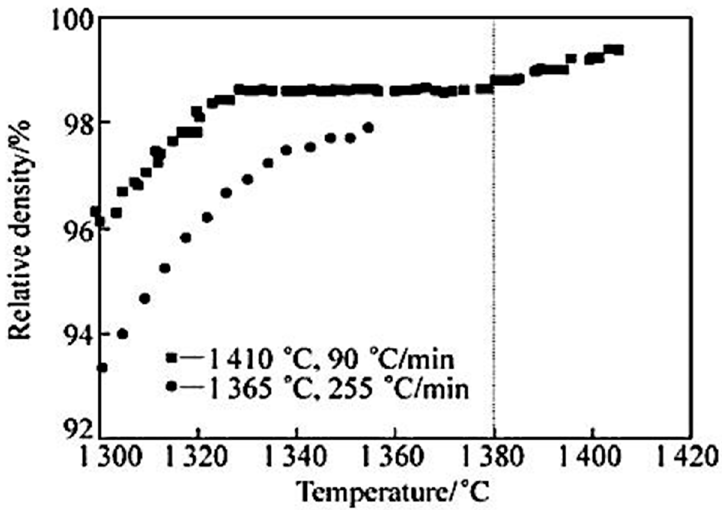
Figure 11. Relative density with sintering temperature [47]. High-current samples had a bigger experimental-to-real temperature discrepancy in the middle position. Temperature gradients in the LPS process changed due to the increased applied current. Different temperatures can’t be controlled at a pace of 90 ◦ C/min in the LPS process. This development can be summarised as follows: Wetting the tungsten particles first helps to distribute the temperature. Later, the solid particle dissolve in the liquid pool, causing them to decrease and reorganize as they dissolve. Finally, the pores between the particles are filled with the melted liquid. Densification, the process by which tungsten particles become spherical due to a reduction in the interfacial energy, eventually